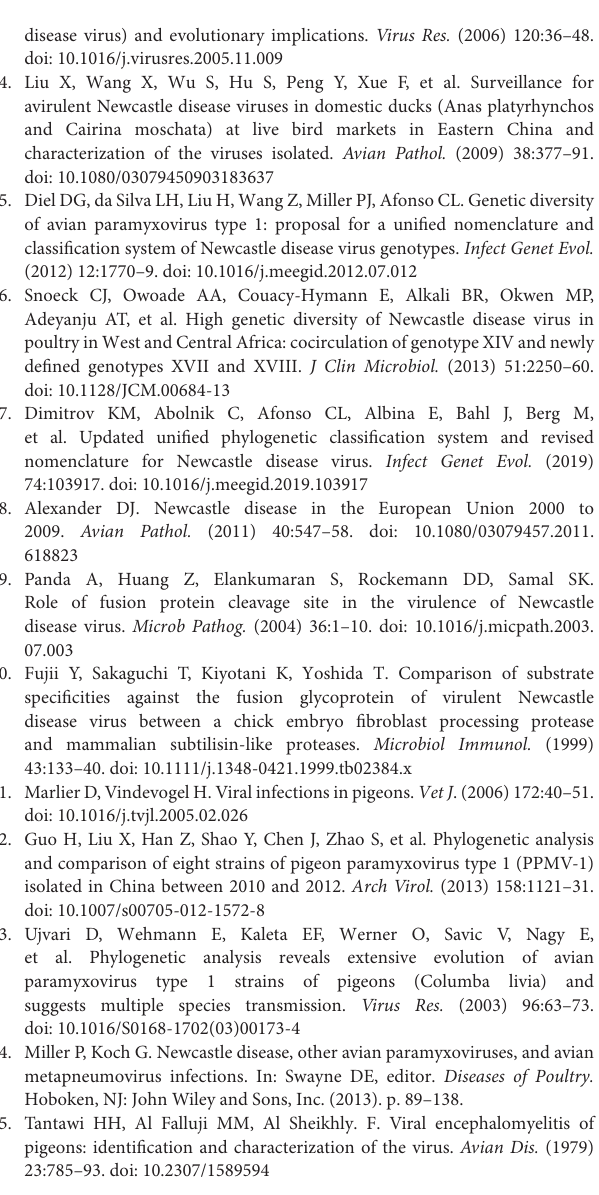
Supplementary Table 1 | Fusion protein analysis in Pigeons. Supplementary Table 2 | Fusion protein analysis in chickens and other birds. Supplementary Table 3 | Functional domains and epitopes in HN of Egyptian NDV strains. Supplementary Table 4 | Head-stalk linker region involved in fusion triggering. Supplementary Table 5 | Vaccination strategies in chickens (NDV). Supplementary Table 6 | Vaccination strategies in pigeons